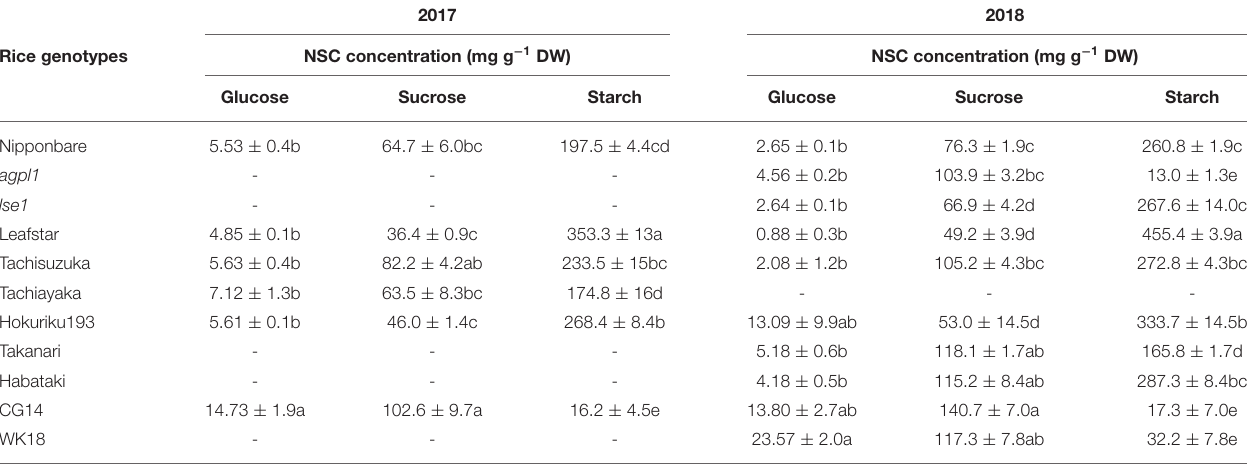
TABLE 2 | Non-structural carbohydrate (NSC) concentrations and nitrogen (N) concentration of stem of various rice genotypes at heading stage in 2017 and